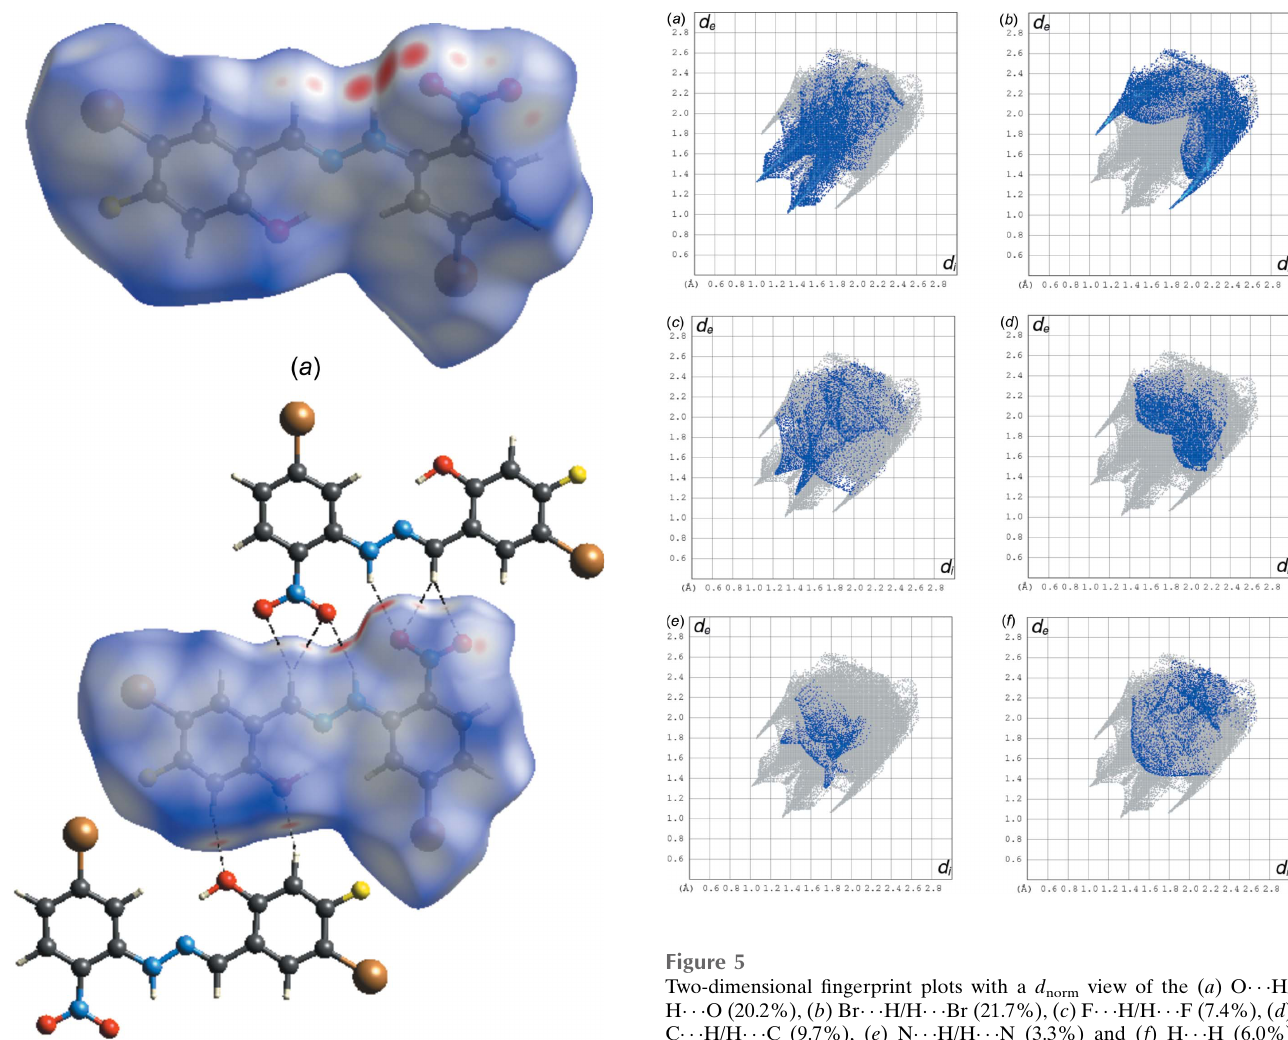
Figure 3 Views of the Hirshfeld surface of the title compound mapped over d norm .